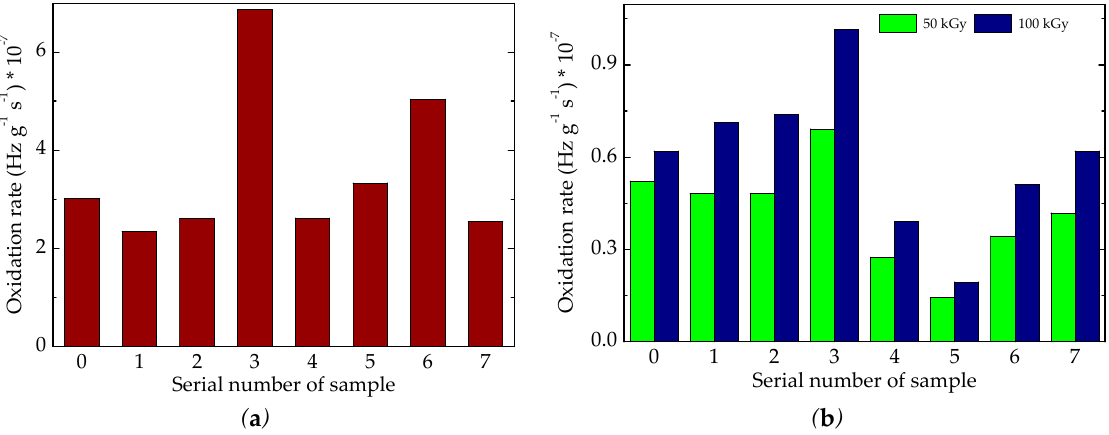
Figure 3. Histograms of oxidation rates for studied hybrids for different γ -exposure doses. ( a ) nonirradiated samples; ( b ) irradiation doses: 50 and 100 kGy.